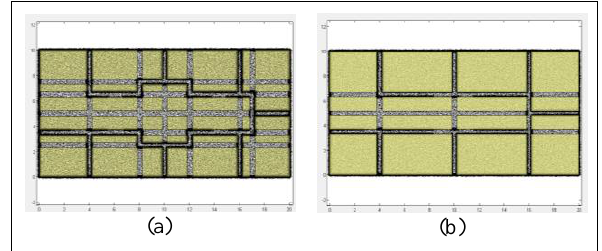
Figure 6. Top view of the cuboids generated by iteratively applying the first rule to subclouds of the first floor (a) and the second floor (b).